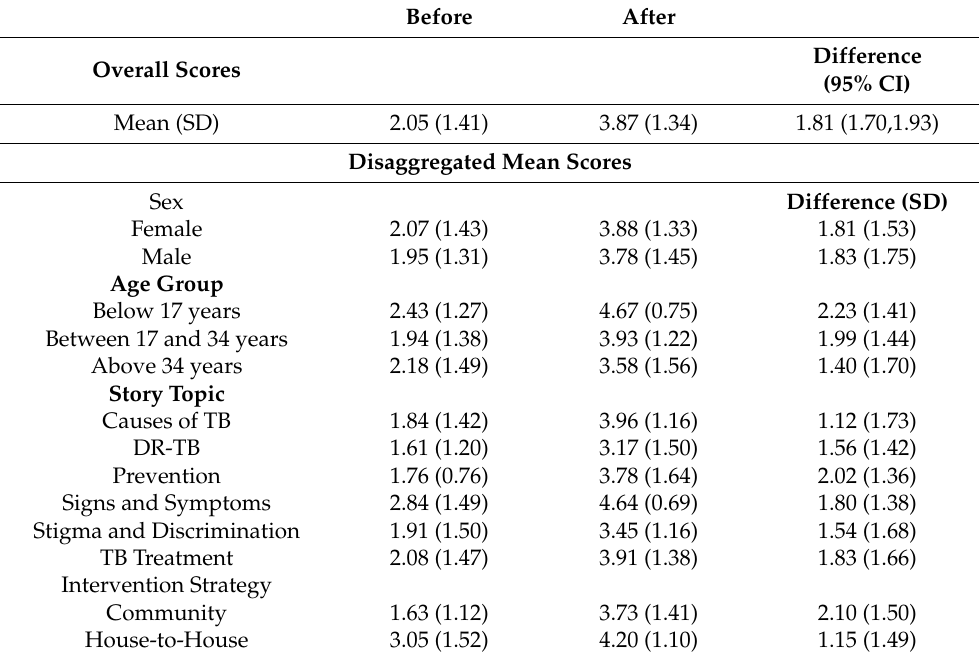
Table 3. Scores for TB knowledge assessment before and after viewing TB stories.